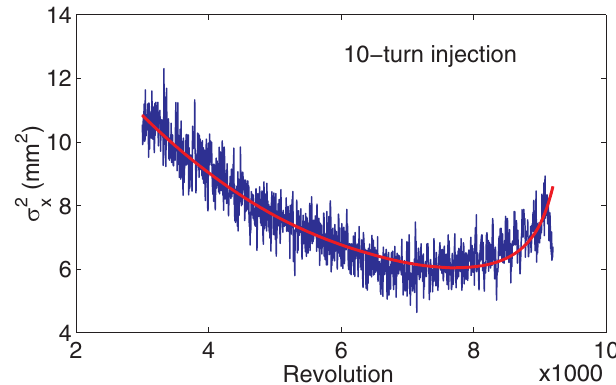
FIG. 17. (Color) An example of the fitting curves using Eq. (11) for the horizontal data sets.